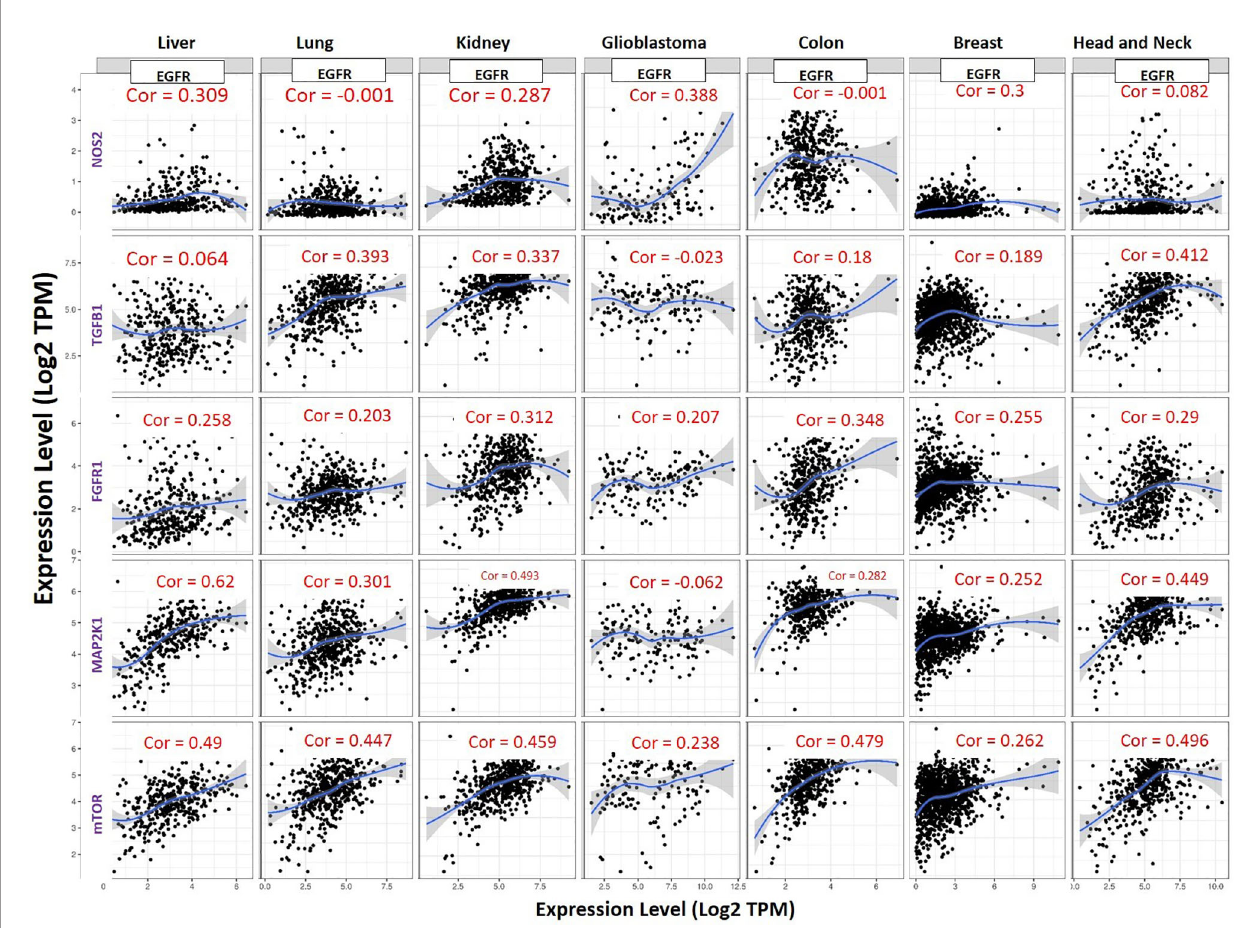
FIGURE 5 | Expression scatterplots of EGFR correlations with NOS2, TGFB1, MAP2K1, mTOR and FGFR1 in multiple cancer types. The strength of correlations between the genes is re fl ected by the purity-adjusted partial spearman ’ s rho value, where a value of r = 1 means a perfect positive correlation and a value of r = − 1 means a perfect negative